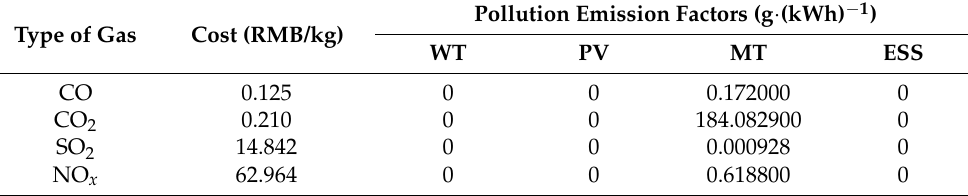
Table 2. Parameters related to pollutant treatment.